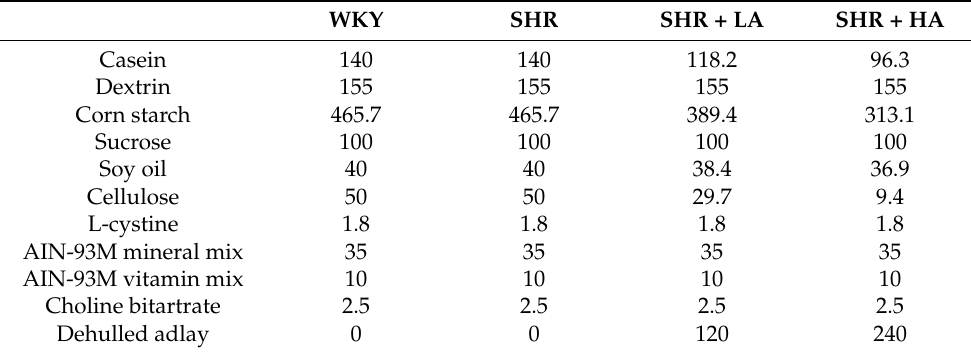
Table 1. Dietary compositions (g/kg) of groups in the murine